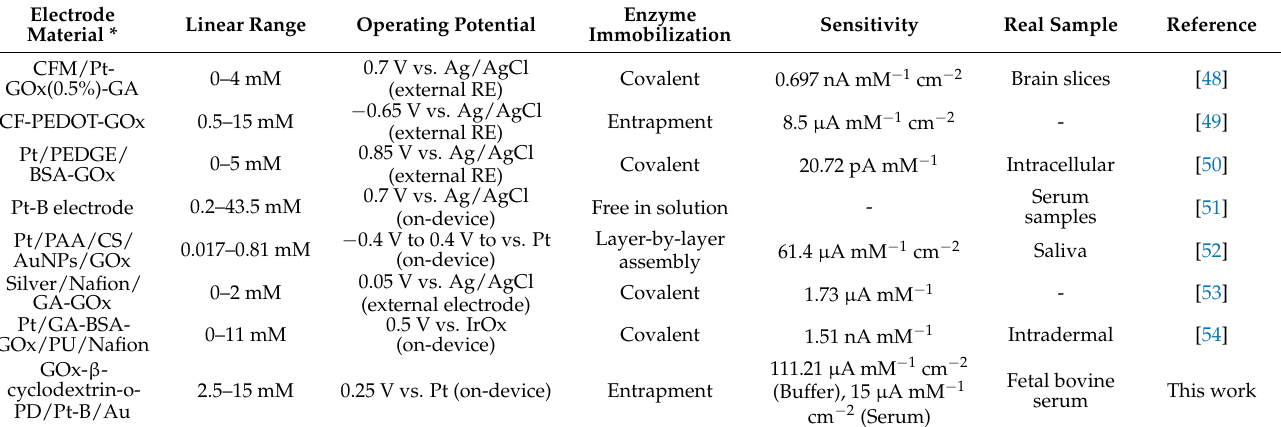
* Abbreviations: CFM: carbon fibre microelectrode, Pt: platinum, GOx: glucose oxidase, GA: glutaraldehyde, CF: carbon fibre, PEDOT: poly (3, 4-ethylenedioxythiophene), PEDGE: poly (ethylene glycol) diglycidyl ether, BSA: bovine serum albumin, PAA: poly (allylamine), CS: chitosan, AuNPs: gold nanoparticles, and PU: